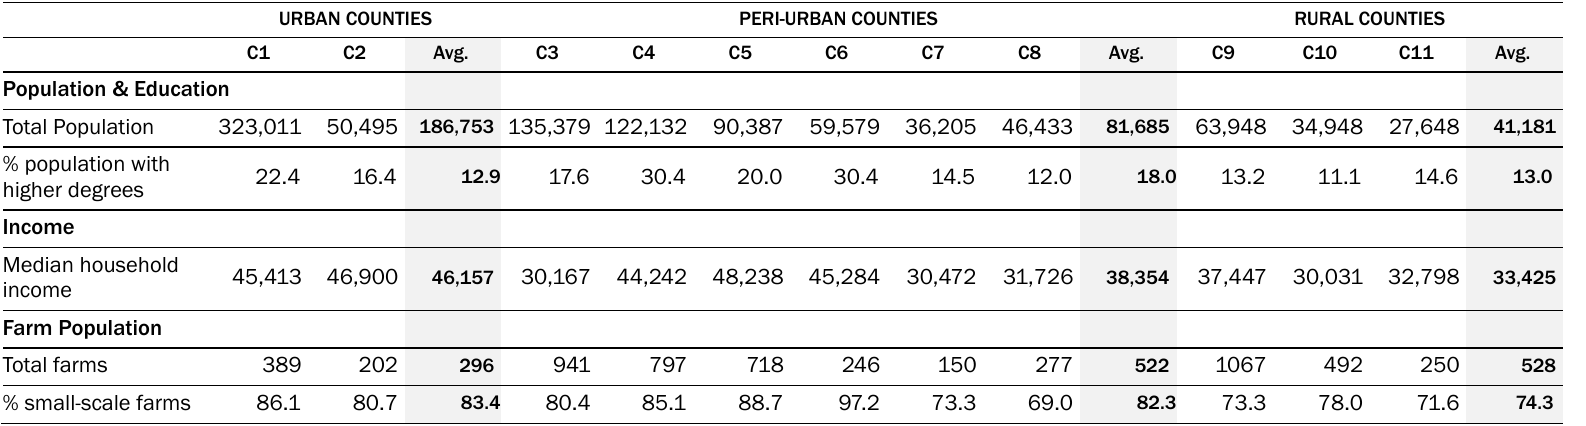
Table 1. County Geographic, Socioeconomic, and Farm